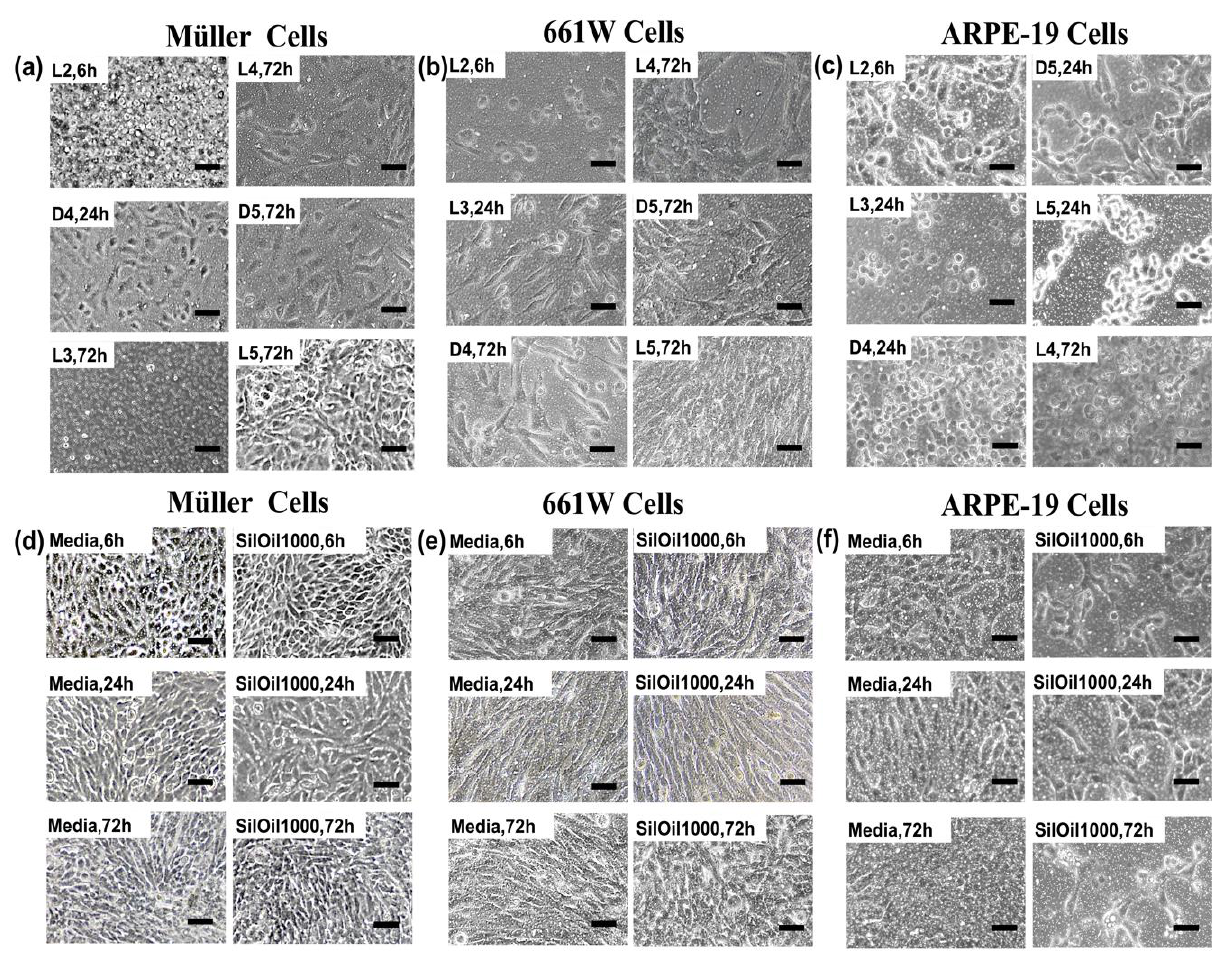
Figure 5. Cell morphology after incubation with emulsified LMWCs. Representative images of ( a ) Müller cells (rMC-1); ( b ) photoreceptor cells (661W); and ( c ) retinal pigment epithelial cells (ARPE-19) after incubation with various types of emulsions at different time points. Morphologies of ( d ) Müller cells (rMC-1); ( e ) photoreceptor cells (661W); and ( f ) retinal pigment epithelial cells (ARPE-19) after incubation with control groups including culture media (media) and emulsion of SilOil 1000 for 6, 24 and 72 h. The results in ( a – f ) are representative of those from 3 independent experiments with 2 replicates each.